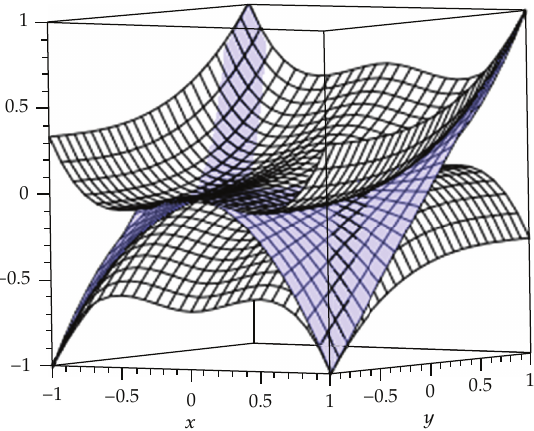
Figure 2: f (cid:3) x,y (cid:4) (cid:2) x 2 y , h ∗